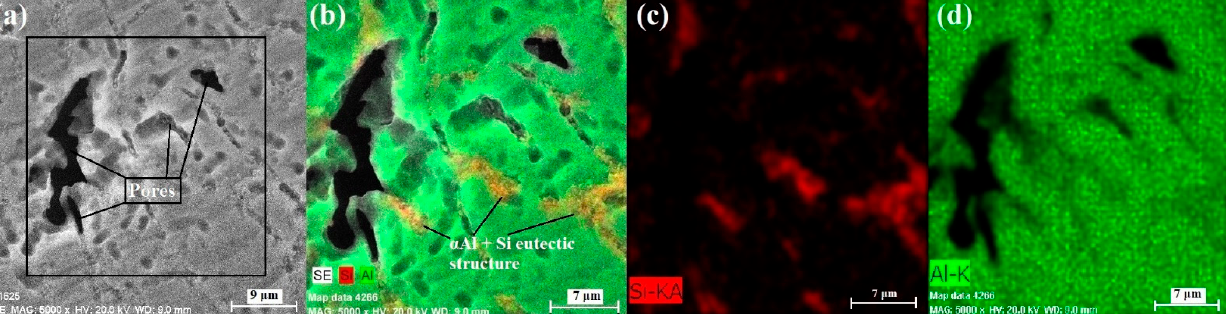
Figure 6. Sample “T” taken from the specimen at a welding speed of 20.0 mm/s: ( a ) SEM micrograph of the studied zone; ( b ) EDX mapping; ( c ) silicon content detected; ( d ) aluminum content detected.